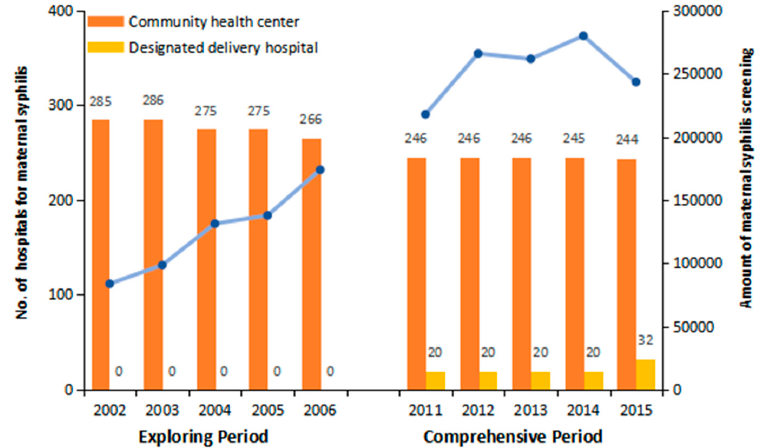
Figure 2. Health facilities for syphilis screening and designed delivery services in the exploring and comprehensive periods.